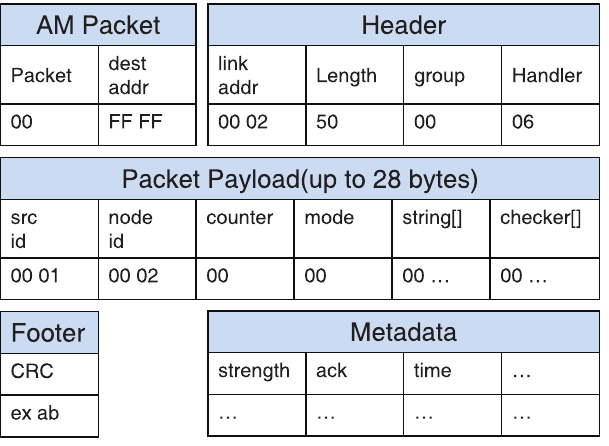
Figure 4. The packet format for the wireless sensor